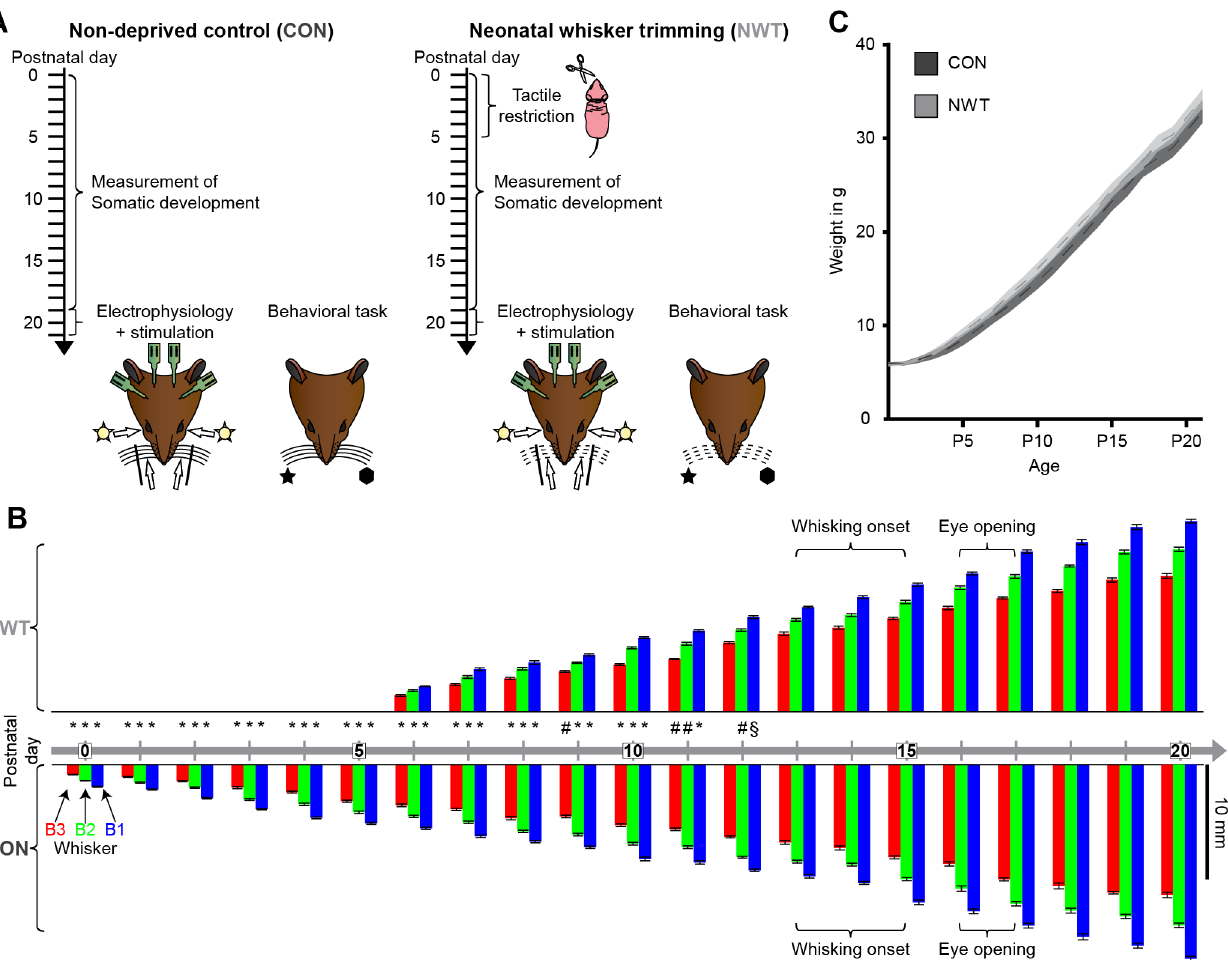
Fig 1. Experimental paradigm, whisker growth, and somatic development of CON and NWT rats. ( A ) Schematic drawing displaying the experimental protocol for the investigation of CON (left) and NWT (right) rats. ( B ) Mean length of three tracked whiskers (B1, B2, B3) averaged for CON ( n = 10, bottom) and NWT ( n = 8, top) rats and displayed for every day during the first three postnatal weeks. The onset of whisking behavior and eye opening are specified on the time line. Significant differences in the whisker length between CON and NWT rats are marked by § ( p < 0.05), # ( p < 0.01), and * ( p < 0.001). ( C ) Plot displaying the weight increase of CON and NWT rats during the first three postnatal weeks. Dotted lines correspond to the mean and transparent area marks the SEM. The underlying data of this figure can be found in S1 Data.